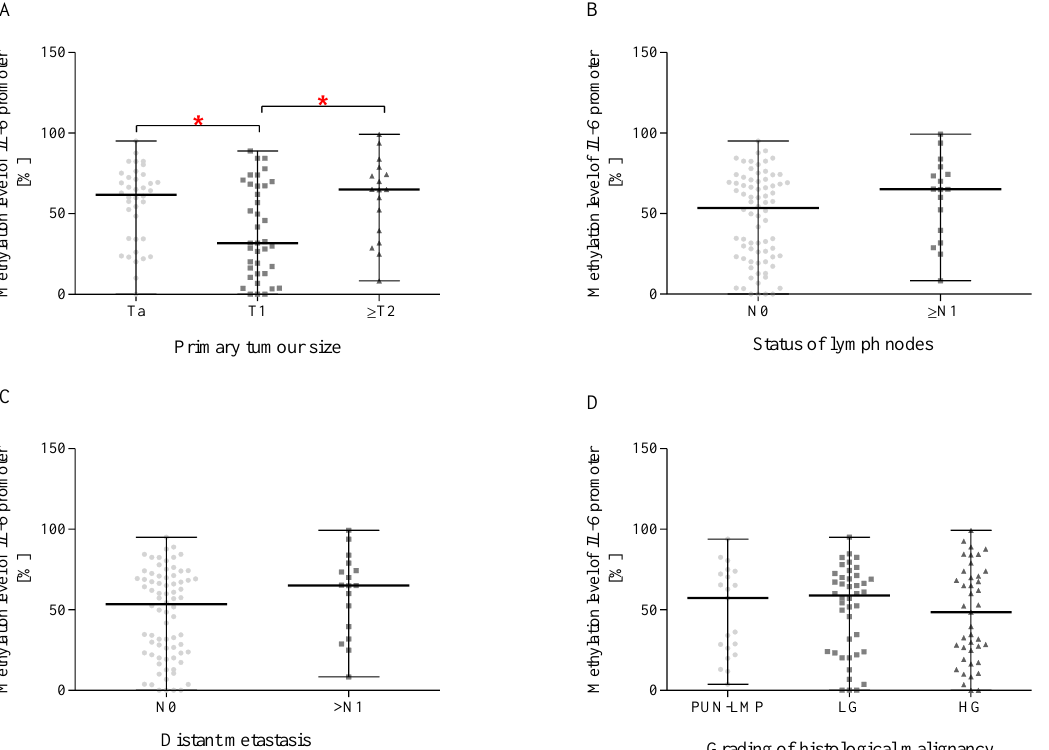
Figure 7. Methylation status of the IL-6 promoter region in terms of primary tumour size groups ( A ), the status of lymph node metastasis ( B ), distant metastasis ( C ), and the grading of histological malignancy ( D ). The data are plotted as individual values and the median with interquartile range is indicated by the horizontal bars; *— p < 0.05.